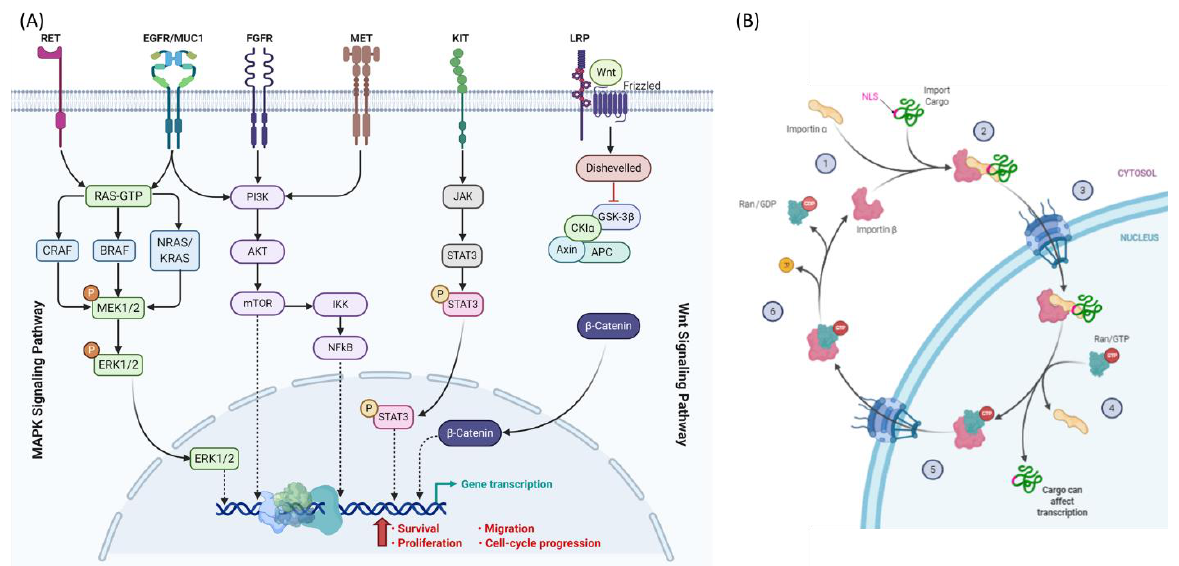
Figure 2. Nucleocytoplasmic translocation. ( A ) Signaling molecules trafficking in the MAPK and WNT signaling pathways in melanoma and thyroid cancer. ( B ) Example for the transport cycle of importins. Import of NLS-containing cargos is mediated by importin αβ. Importin α recognizes and binds the NLS of the cargo as well as importin β. After transport through the nuclear pore channels (NPC), the GTP-bound GTPase Ran binds to importin β and dissociates the import complex. Next, Ran/GTP transports the complex across the NPC into the cytoplasm. Hydrolysis of GTP to GDP is stimulated by Ran binding protein 1 and Ran GTPase activating protein 1 in the cytoplasm. Conformational rearrangements in Ran/GDP lead to the dissociation of importin β to be free for the next cycle. Created with BioRender.com .